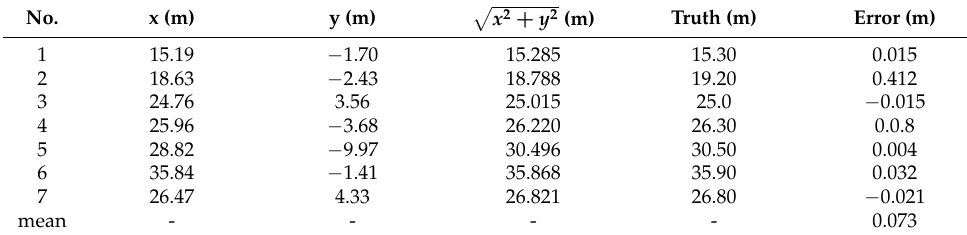
Figure 16. Two test screenshots are shown. ( a ) The results of image detection and tracking. The target is marked with a green box, and the point cloud in ( b ) is also marked with a green box to indicate the spatial position relative to the perception module. Table 3. Relative Positioning error.